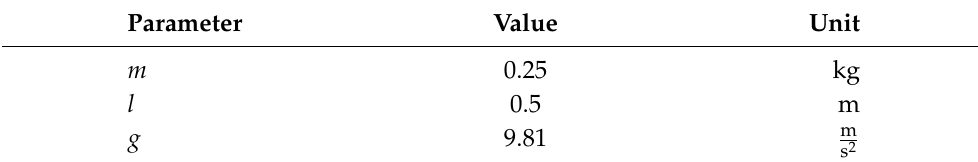
Table 1. Parameters of the robot.